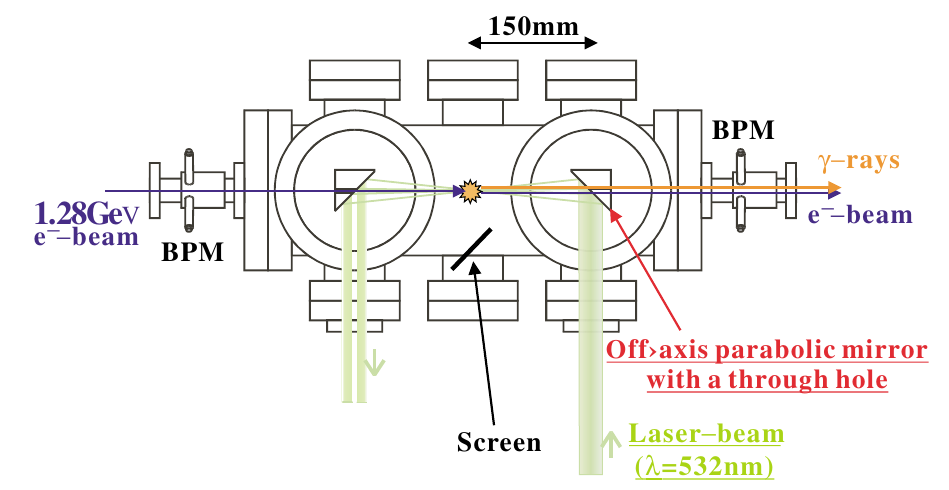
FIG. 11. (Color) Top cross-sectional view of the Compton chamber.